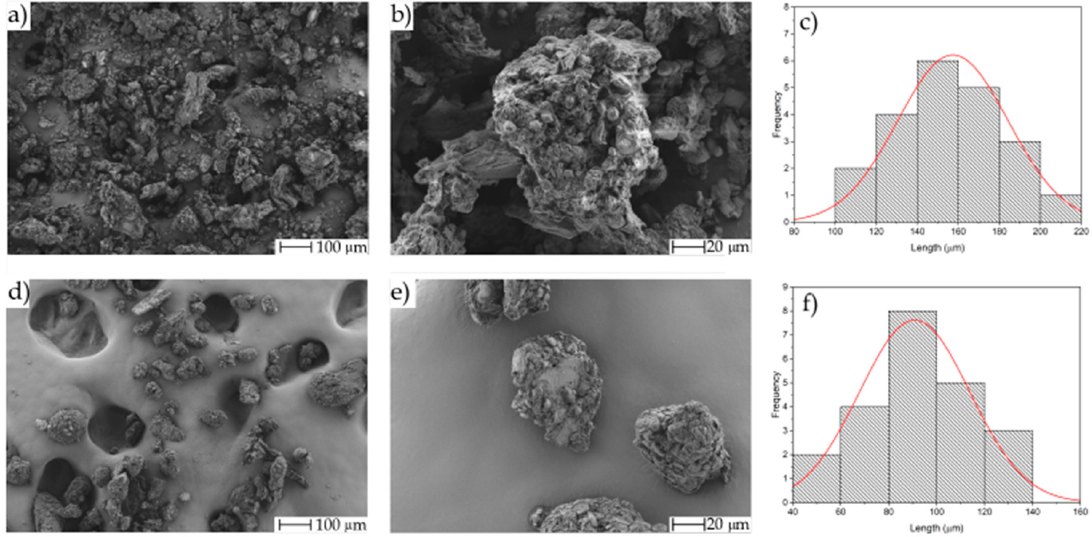
Figure 2. Field emission scanning electron microscope (FESEM) images corresponding to ( a ) CFF at 100 × with a scale marker of 100 µ m; ( b ) CFF at 500 × with a scale marker of 20 µ m; ( c ) particle size histogram of CFF; ( d ) FFF at 100 × with a scale marker of 100 µ m; ( e ) FFF at 500 × with a scale marker of 20 µ m; ( f ) particle size histogram of FFF.